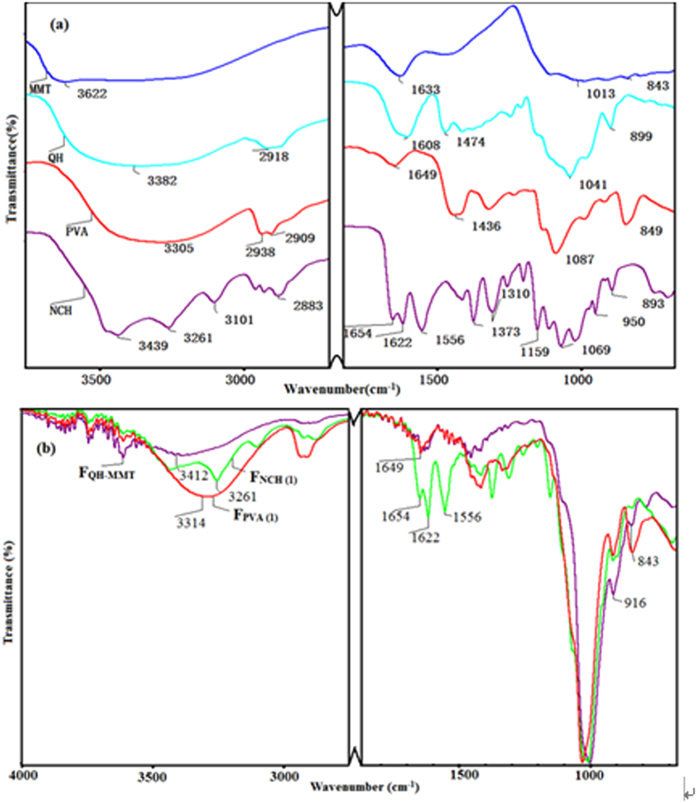
FT-IR spectra of MMT, QH, PVA and NCH (a). FT-IR spectra of the three types of composite films (FQH-MMT, FNCH(1), FPVA(1)) (b).